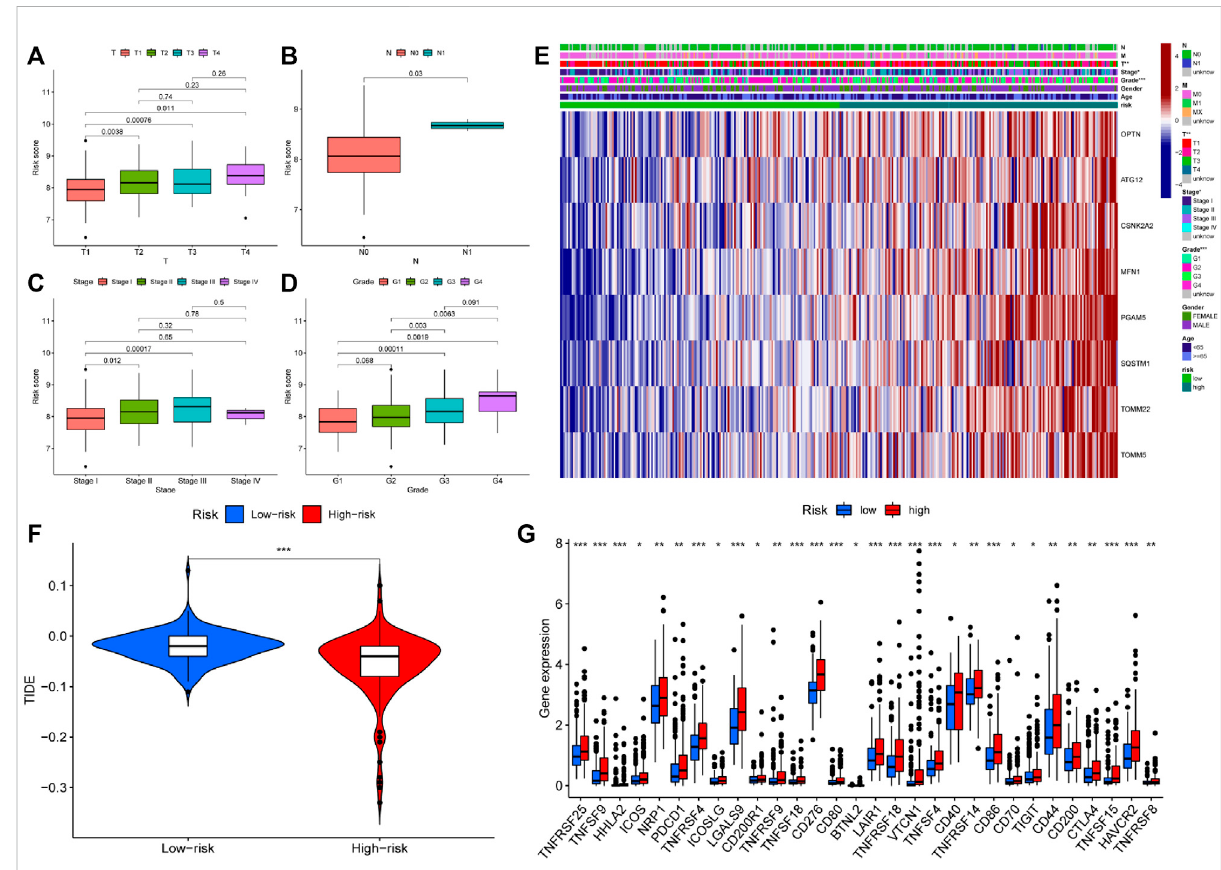
FIGURE 6 Differencesinclinicalfeaturesandef fi cacyofimmunotherapyamong patientswith differentriskscores (A – D) Risk scorewascorrelatedwith T, N, Stage and Grade; ( E) The expression of prognostic related genes in clinical factors and different risk groups; ( F) The violin chart of patients ’ response to immunotherapy in high and low-risk groups. Blue represented low-risk group, red represented high-risk group; ( G) Expression of immune checkpoints in two risk subgroups. * represented p < 0.05, ** represented p < 0.01, and *** P represented <